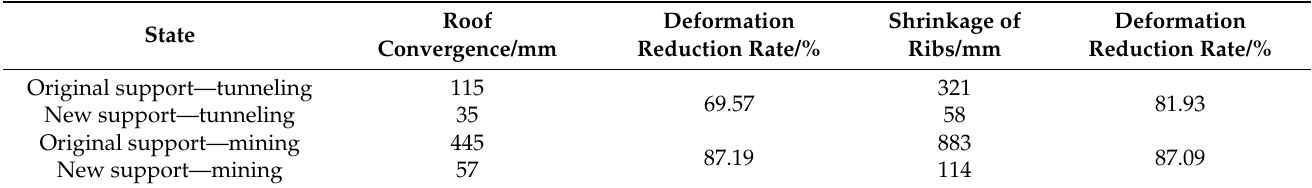
Figure 9. Monitoring data of roadway deformation under new support: ( a ) roadway deformation during tunneling and ( b ) deformation of roadway during mining of adjacent working face. Table 1. Comparison of roadway deformation under original support and new